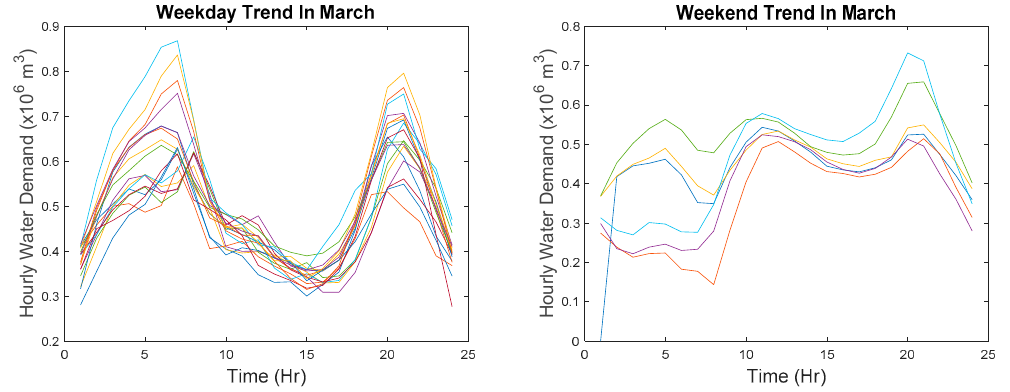
Figure 7. Extracted weekday and weekend water demand trend.